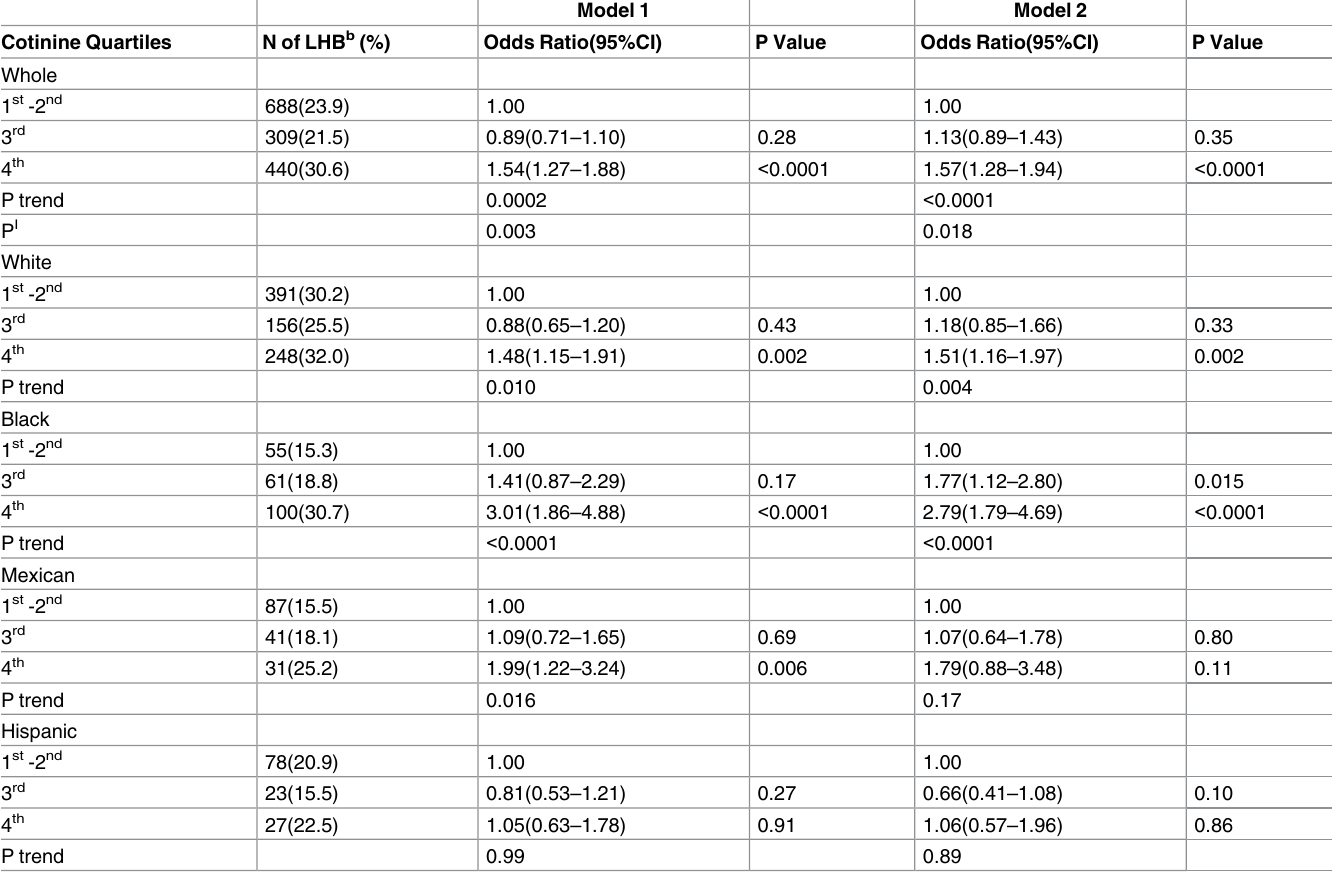
Table 3. Associations of quartiles of cotinine with HOMA-B by